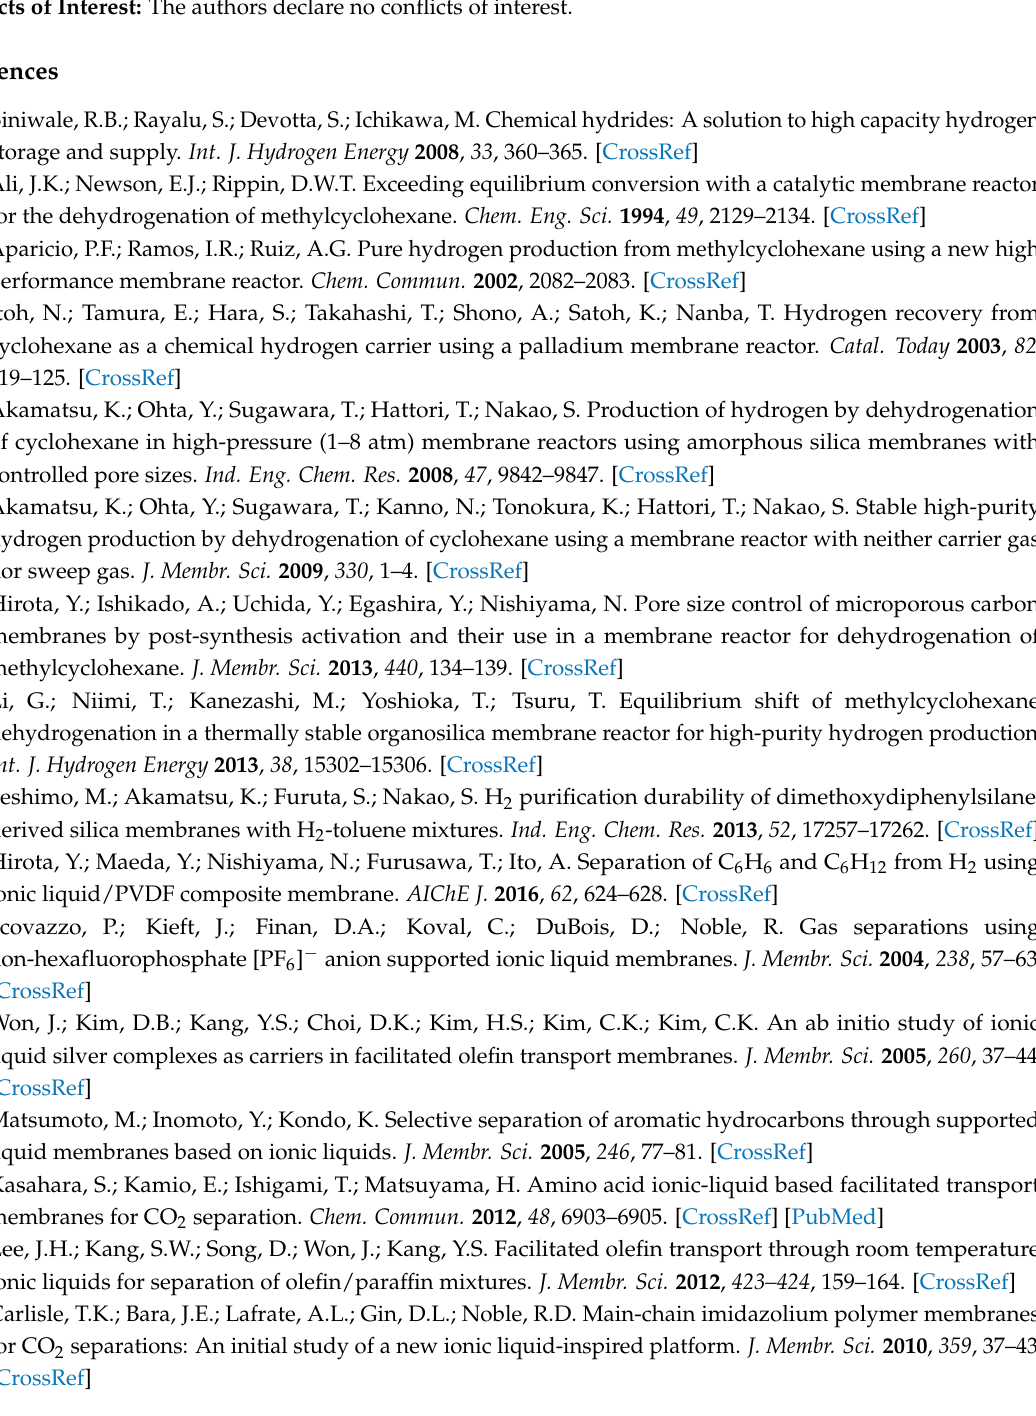
test apparatus, Figure S3: Cross-sectional (a) SEM image and (b) EDX chemical map for F atoms of the ILOS membrane. (White dot represents F